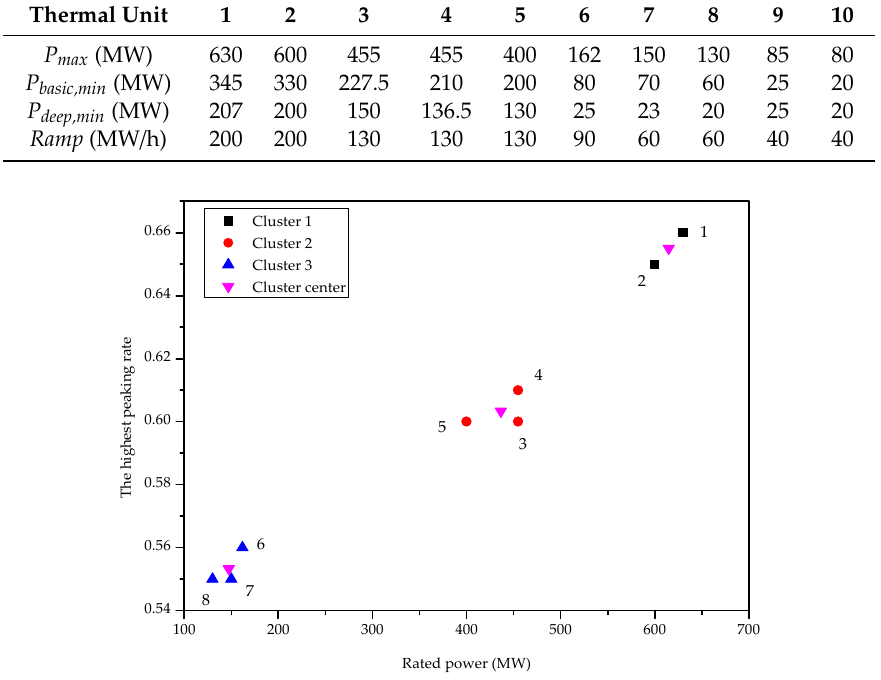
Figure 4. Cluster analysis of peaking thermal units.